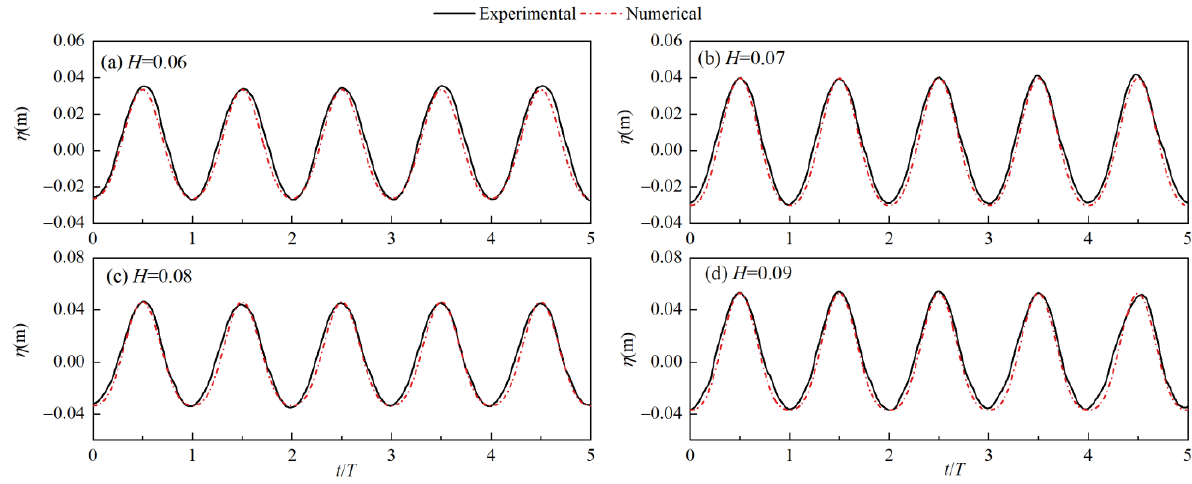
Figure 3. Comparison of the water elevation between the measured data and the theoretical solutions for typical cases: ( a ) H = 0.06 m, ( b ) H = 0.07 m, ( c ) H = 0.07 m, ( d ) H = 0.08 m ( d = 0.285 m, T = 0.9 s).